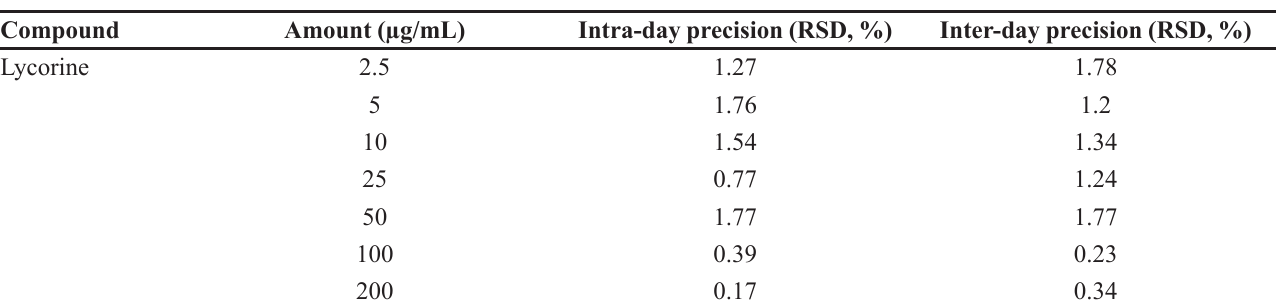
TABLE II - Intra-day and inter-day precision of the method Compound